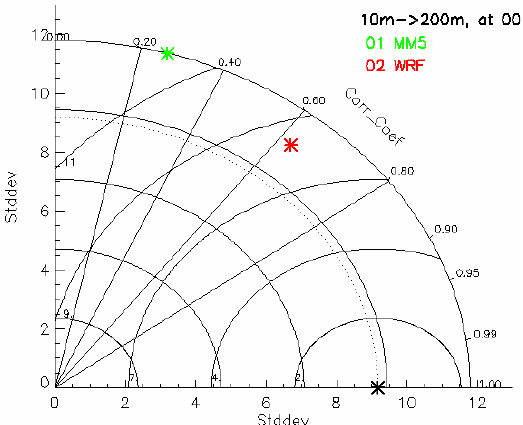
Fig. 3b. Statistics (Taylor plot, Taylor, 2001) for vertical potential temperature gradient profiles (10m–200m) by WRF, MM5 for the Linate airport, together with the observations for 00:00h for the whole year.